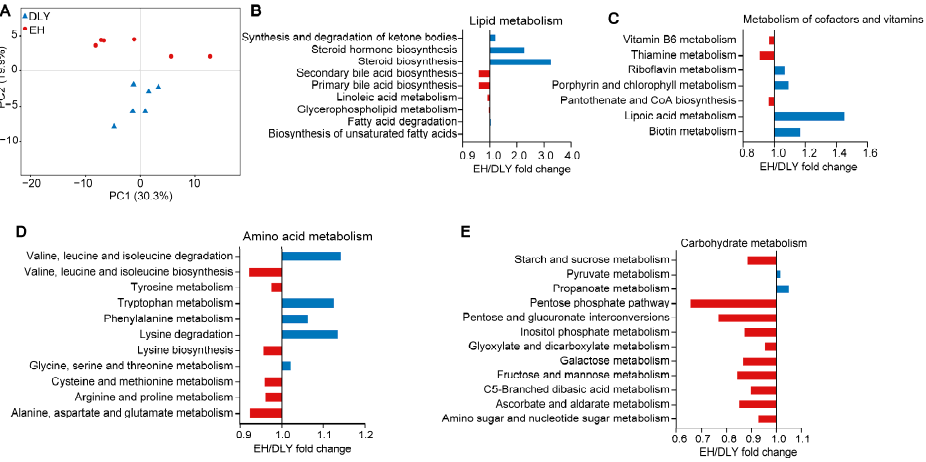
Figure 4. EH/DLY fold change showed differences in KEGG level-3 microbial metabolic pathways between DLY and EH pigs. ( A ) The metabolism profiles of gut microbiota of DLY and EH pigs based on KEGG level-3 “Metabolism” pathways visualized by PCA. ( B ) Lipid metabolism. ( C ) Metabolism of co-factors and vitamins. ( D ) Amino acid metabolism. ( E ) Glucose metabolism. 3.3. Correlations between Different Microbial Genera and Skeletal Muscle Phenotypes of Pigs The correlations of different gut microbial genera with skeletal muscle phenotypes (fiber diameter and density) were examined by Spearman’s rank correlation analysis. All 35 significantly different genera showed significant relationships with the fiber diameters and densities of skeletal muscle (coefficient R > 0.50 or < − 0.50; p < 0.05; Figure 5A). The different microbes that were highly positively associated with fiber density and highly negatively associated with fiber diameter (coefficient ρ > 0.70 or < − 0.70; p < 0.001) were considered phenotype-correlated microbial genera. Twelve phenotype-correlated micro- bial genera were detected in this study, including Succinivibrio, Parabacteroides, and Sut- terella (Figure 5A). A correlation analysis revealed 397 significant correlations (coefficient R > 0.50 or < − 0.50; p < 0.05) between phenotype-correlated microbial genera and significantly different KEGG level-3 “Metabolism” pathways. The top nine highly positive correlations were all related to the “Steroid biosynthesis” pathway (coefficient ρ > 0.85; p < 0.0001; Figure 5B). Succinivibrio, Parabacteroides, and Sutterella were the gut microbes with the three high- est correlations with this pathway (coefficient R > 0.93; p < 0.0001). The high steroid bio- synthesis in the skeletal muscle indicated high intramuscular fat in the better quality meat. Therefore, these gut microbes may contribute to the high quality of the skeletal muscle.